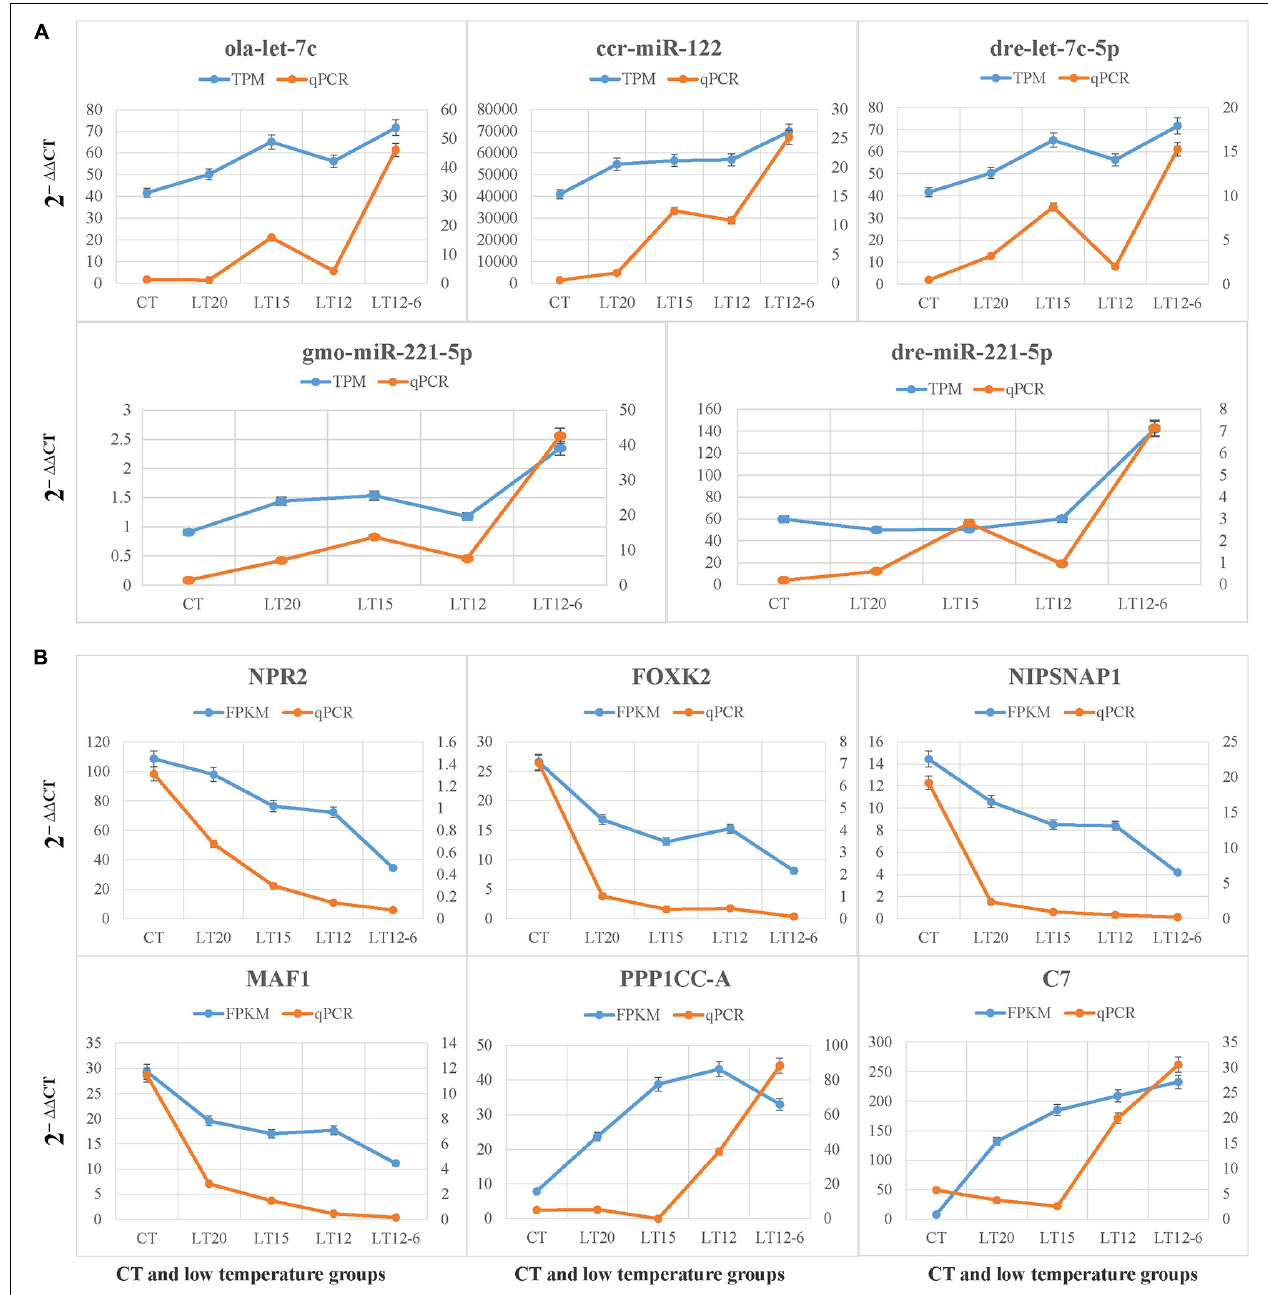
FIGURE 10 | qRT-PCR validation of five miRNAs (A) and six target genes (B) in all